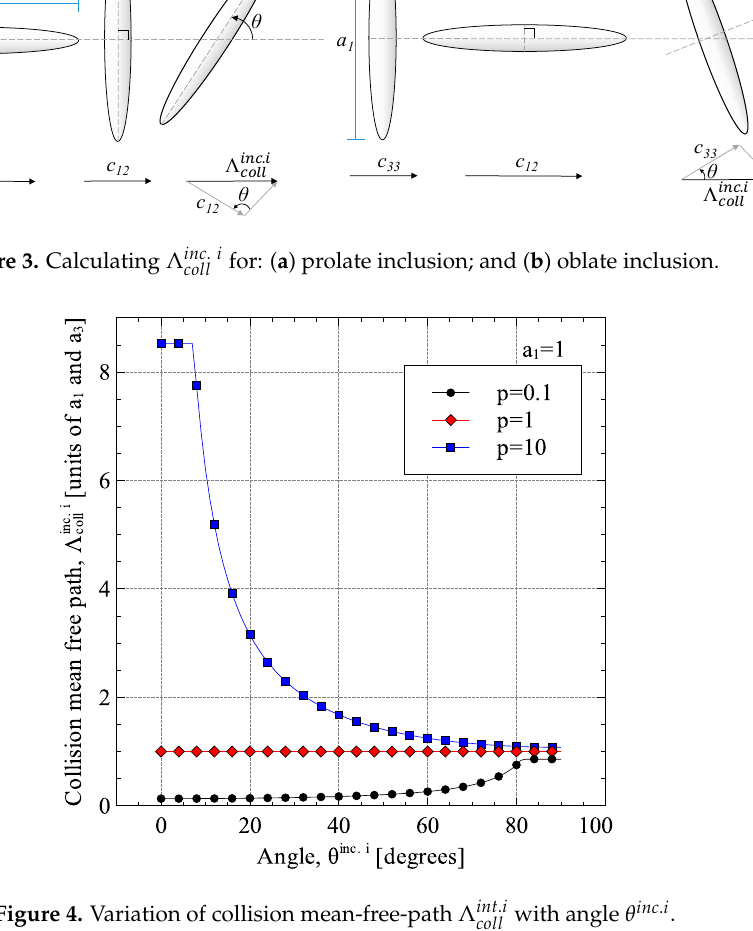
with angle θ inc . i coll